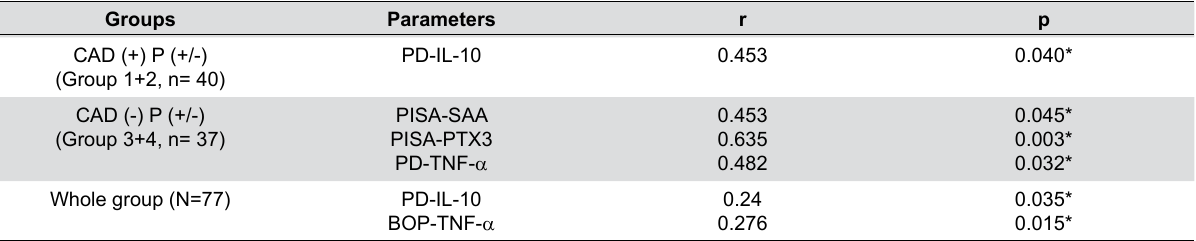
Table 4- Statistically significant correlations between serum cytokine and APR levels, systemic inflammatory burden and clinical periodontal parameters